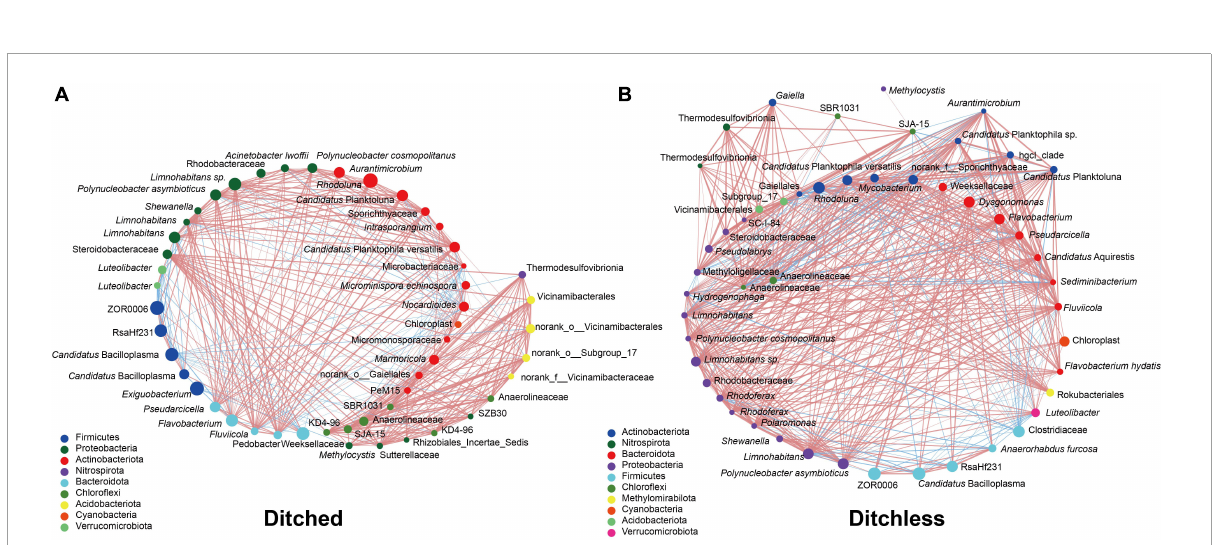
FIGURE5 Combined analysis of bacterial community structures of water, sediment and intestine. Correlation network (A,B) of water, sediment and intestine in the ditched (A) and the ditchless (B) system. The size of the dots indicates the abundance of the most 50 OTUs. The red and blue lines indicate positive and negative correlations between the connecting points,